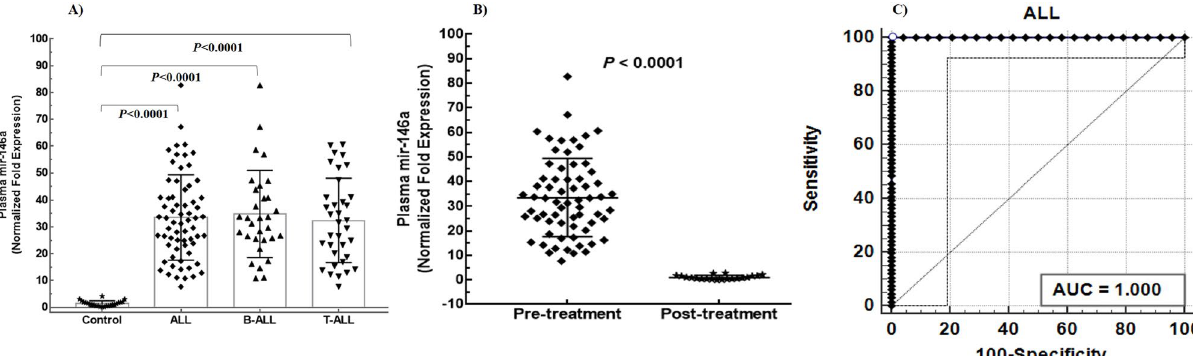
Figure 1. Normalized fold expression of plasma mir-146a. ( A ) Relative quantification of plasma mir-146a in patients with ALL (n = 84), B-ALL (n = 48), T-ALL (n = 39), and healthy controls (n = 25). The y-axis denotes relative expression of plasma mir-146a normalized to mir-16 as a reference gene. ( B ) The levels of plasma mir- 146a significantly reduced after treatment in patients of ALL (P < 0.0001). ( C ) Receiver operating curve (ROC) analyses for ALL with an AUC of 1.00 representing 100% sensitivity and 100% specificity.